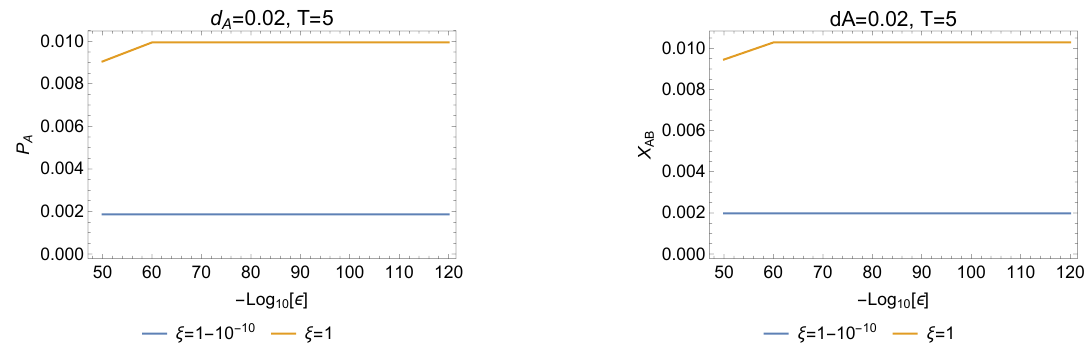
to the UV-regulator can be estimated as j P jj X ( (cid:15) = 10 (cid:0) 119 ) j(cid:0)j X ( (cid:15) = 10 (cid:0) 120 ) jj (cid:25) 10 (cid:0) 12 for (cid:24) = 1 (cid:0) 10 (cid:0) 10 and j P 10 (cid:0) 120 ) j (cid:25) 10 (cid:0) 9 and jj X ( (cid:15) = 10 (cid:0) 119 ) j (cid:0) j X ( (cid:15) = 10 (cid:0) 120 ) jj (cid:25) 10 (cid:0) 10 for (cid:24) = 1. These